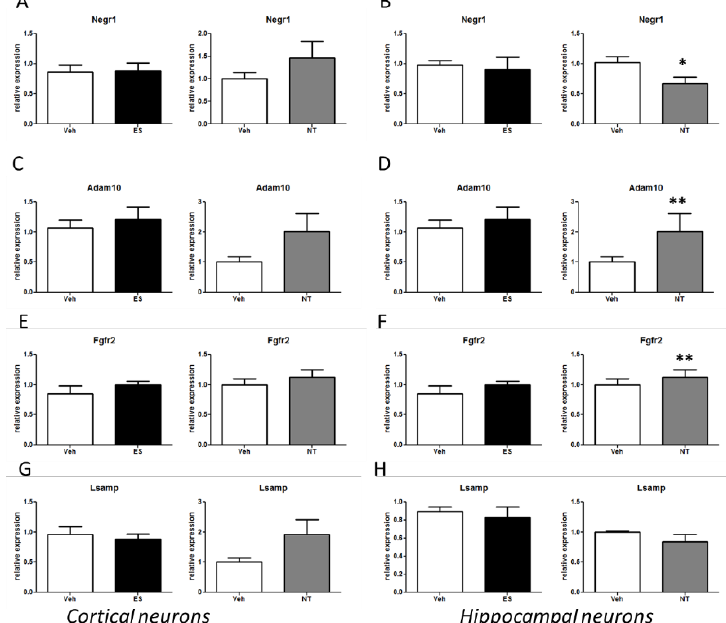
Figure 5. mRNA levels of genes belonging to the Negr1-Fgfr2 pathway in cortical and hippocampal cultures after ES or NT or vehicle administration. Cultures were treated every second day from DIV5 to DIV14 either with escitalopram (ES, 5 µ M) and vehicle (DMSO) or nortriptyline (NT, 1 µ M) and vehicle (water). ( A , B ) Negr1 expression in hippocampal or cortical neurons; ( C , D ) Adam10 expression; ( E , F ) Fgfr2 expression; and ( G , H ) Lsamp expression. Data are expressed as mean ± S.E. * p < 0.05, ** p < 0.01 Student’s T-test, n =